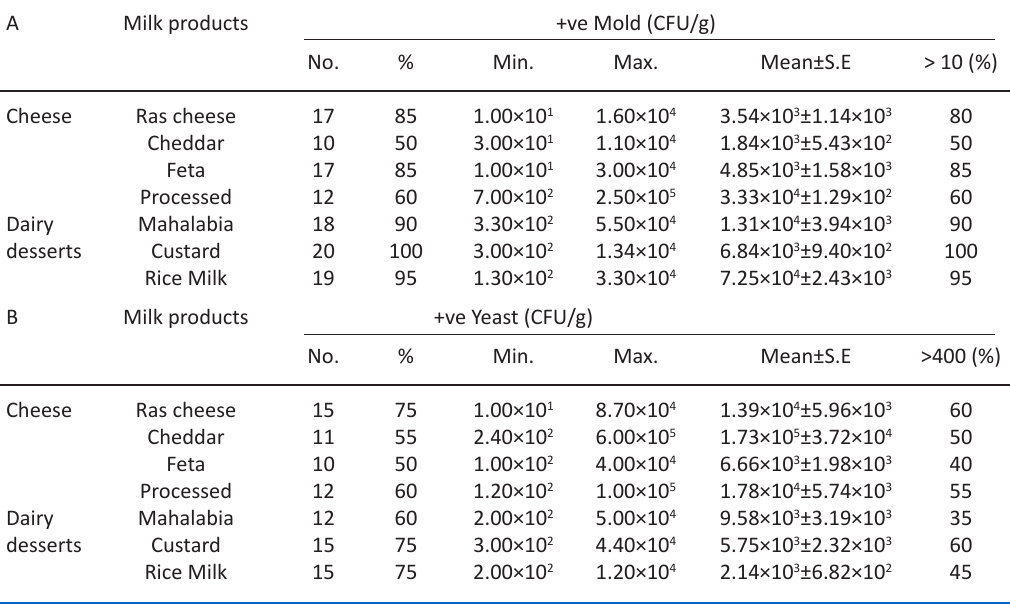
Table 1. Mold and yeast counts, presented as colony forming unit (CFU)/g, in different dairy products’ samples (n = 20), showing the safety from mold and yeast according to EOSQC